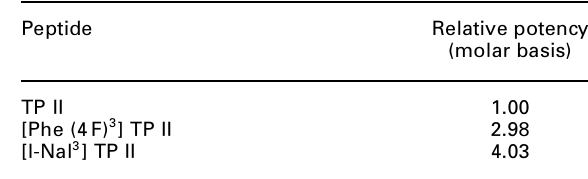
Table 2. Relative potencies of synthetic TP II, [Phe (4F) 3 ] TP II and [l-Nal 3 ] TP